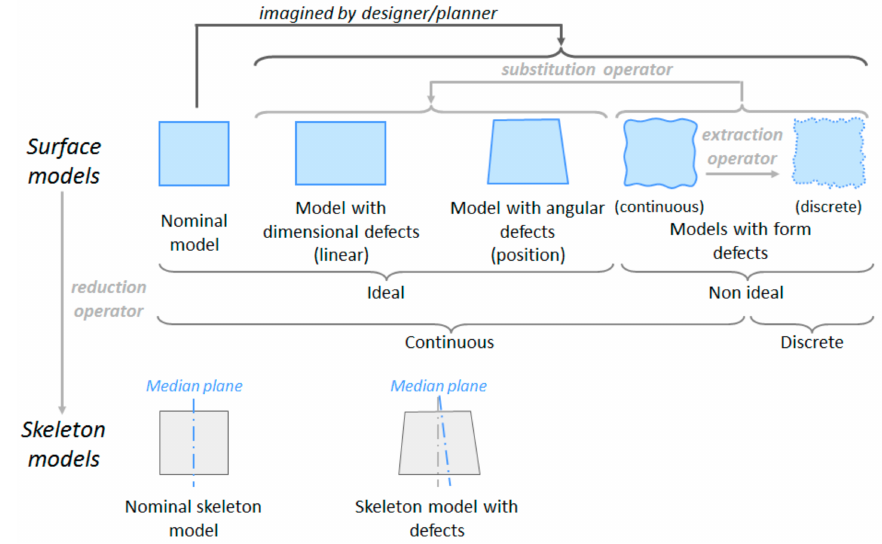
Figure 3. Geometry models for product/process